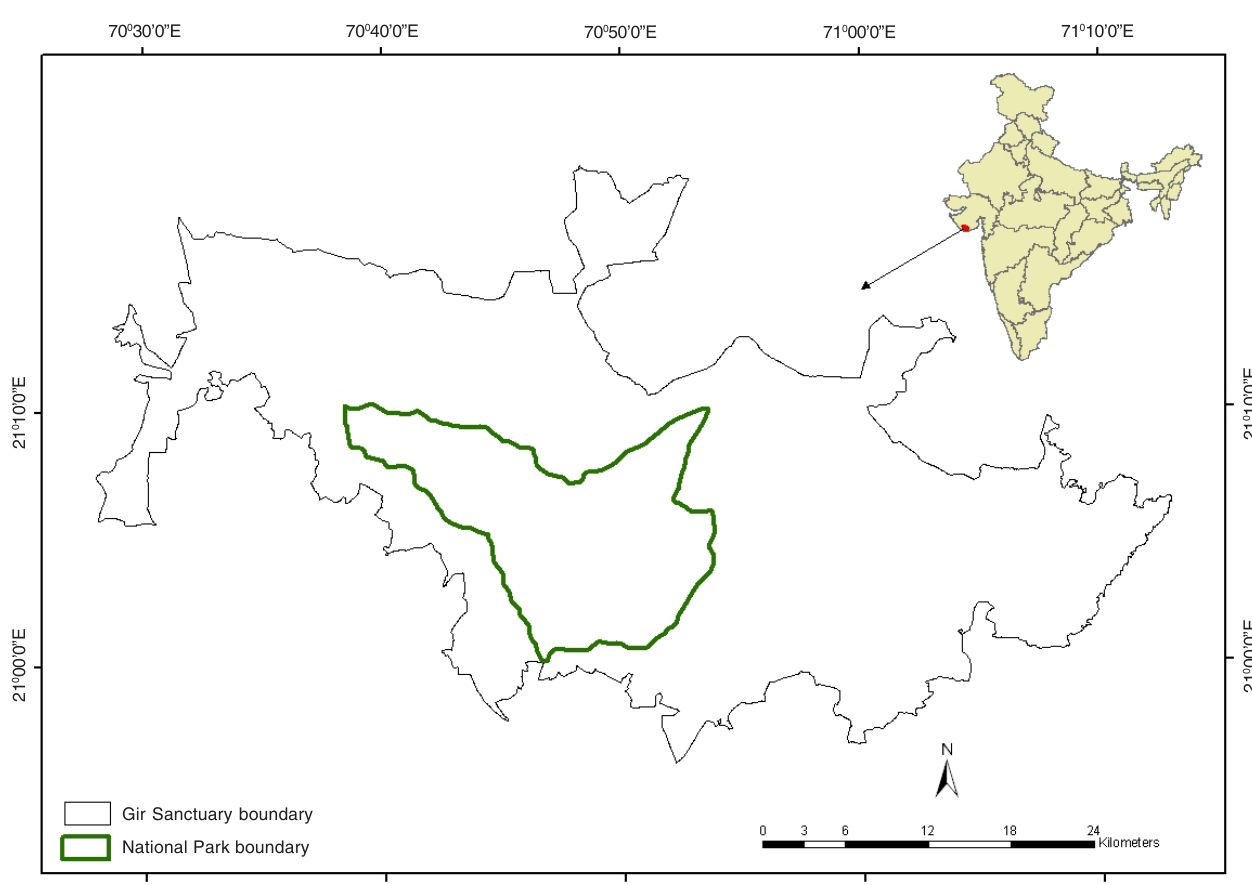
Figure 2. Location of the Gir Sanctuary and National Park in western